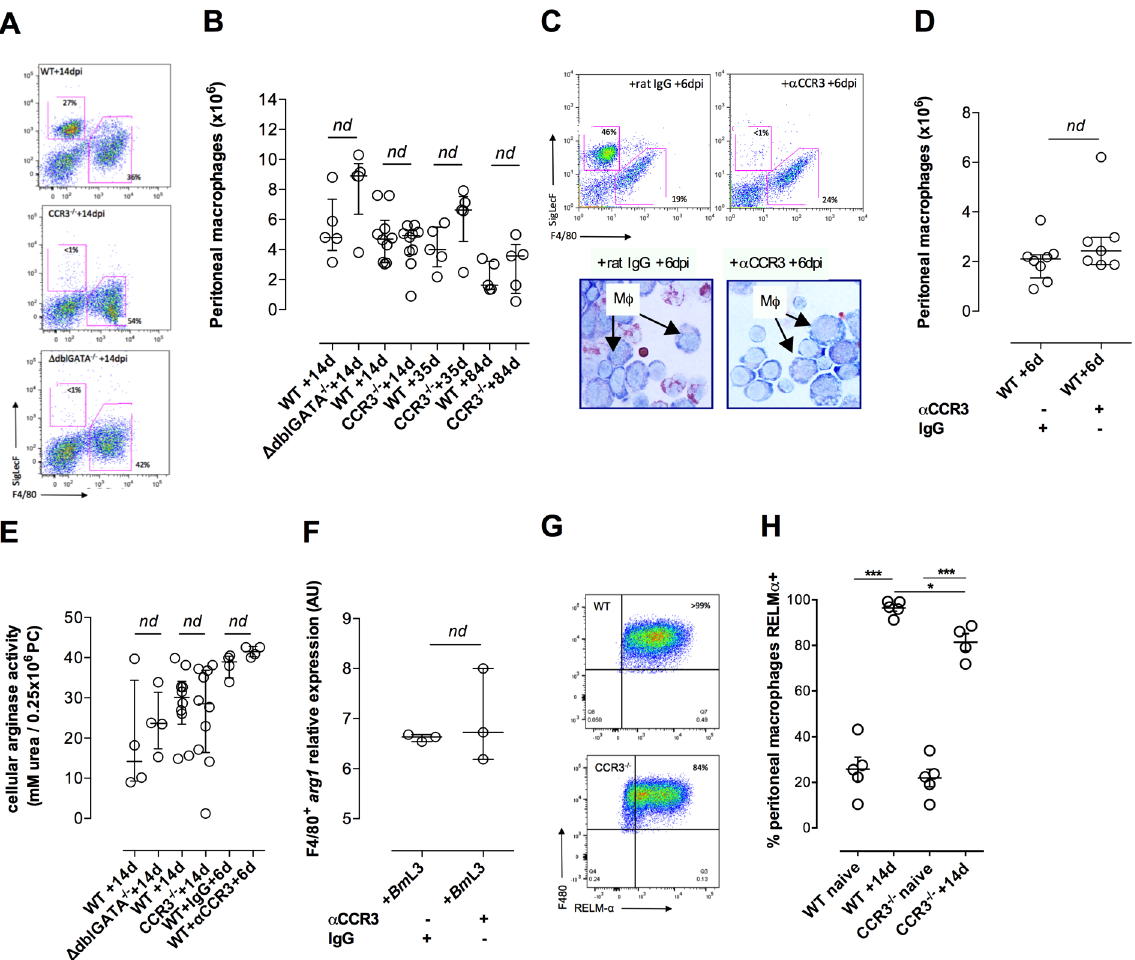
Fig 4. Eosinophilia does not impact on expansion of arginase-expressing AAM ϕ but augments RELM α production. Expansion of peritoneal M ϕ in BALB/c WT, Δ dblGATA deficient mice or CCR3 deficient mice (A,B) or in WT mice treated ip with rat IgG control or rat α CCR3 (C,D) at indicated time points post-ip infection with 50 Bm L3. Arginase activity in PC cells from BALB/c WT, Δ dblGATA deficient or CCR3 deficient mice, WT mice treated ip with rat IgG control or rat α CCR3 (E) and expression of arg1 in purified M ϕ from WT mice treated ip with IgG control or α CCR3 (F) at indicated time points post-ip infection with 50 Bm L3. F4/80 peritoneal M ϕ expression levels of RELM α in BALB/c WT or CCR3 -/- mice at +14 day post-infection with 50 Bm L3 (G,H) . Data from individual mice with median and interquartile range are plotted. Significant differences between groups assessed by Mann-Whitney or Kruskal-Wallis + Dunn’s tests ( > 2 groups). Data is from an individual experiment or pooled from 2–3 individual experiments per time-point using groups of 3–6 mice per group /